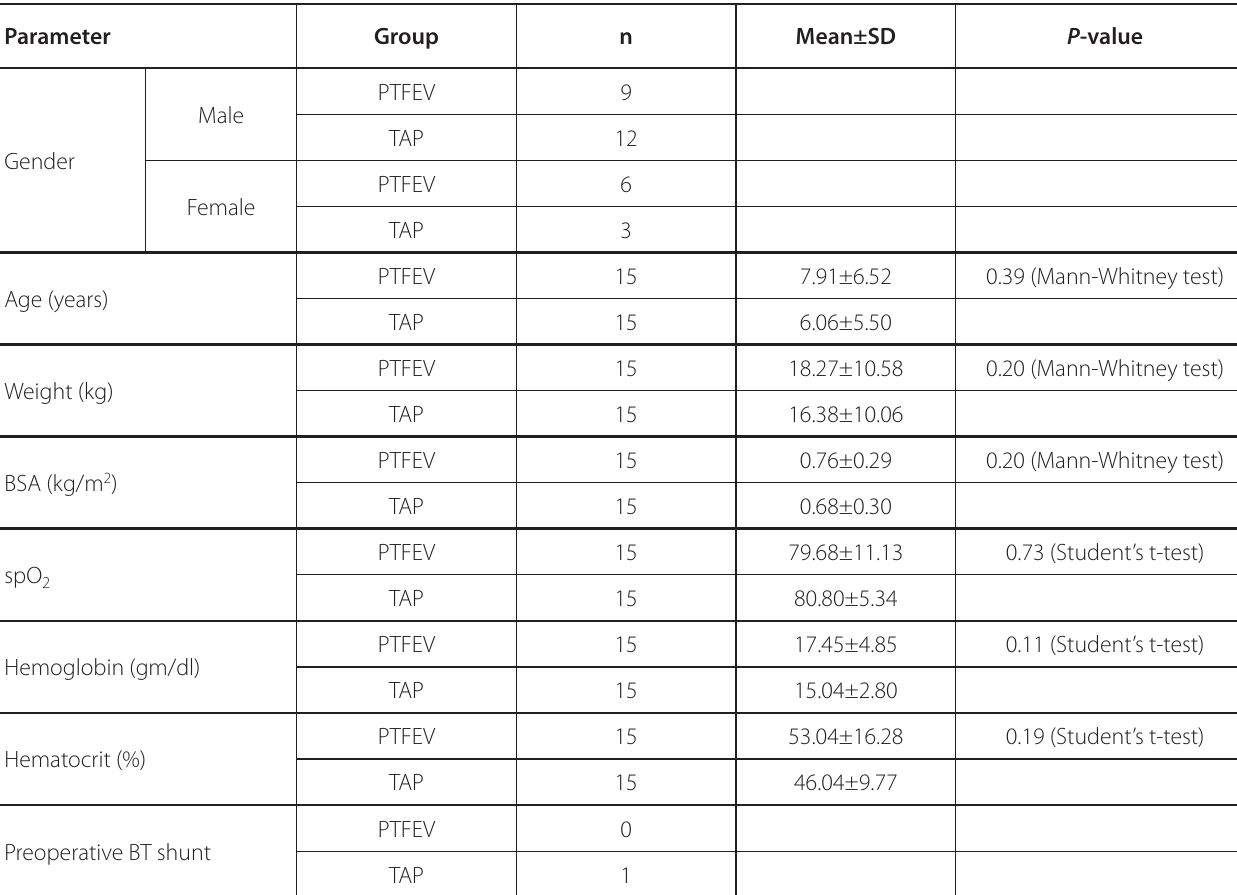
Table 1 . Preoperative baseline characteristics. Parameter